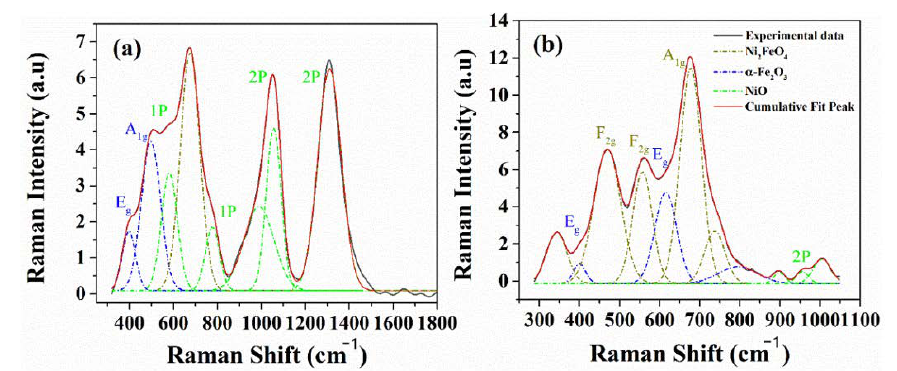
Figure 3. The deconvoluted Raman peaks corresponding to the ( a ) FNN-221 and ( b ) FNN-211 samples, respectively.